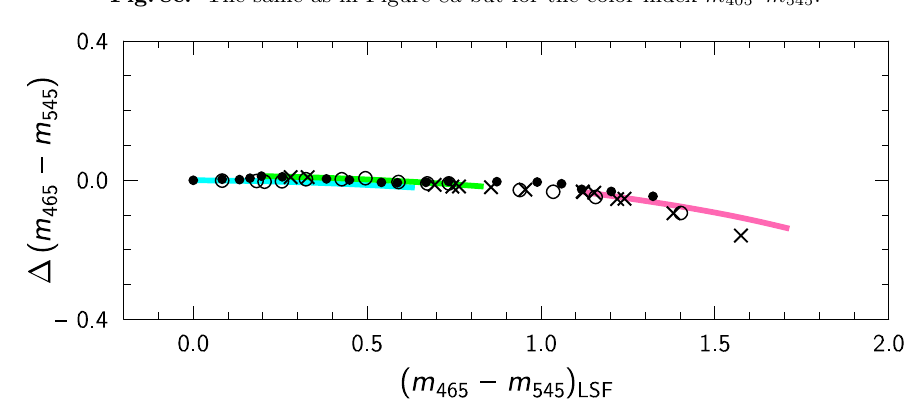
Fig. 8c. The same as in Figure 8a but for the color index m 405 – m 545 .